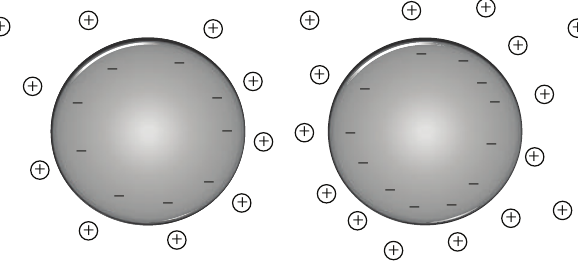
Figure 2: Two colloidal particles (large spheres) in suspension, showing the distribution of ions (small circles) around them, which give rise to screening of the long range electrostatic interaction, yielding